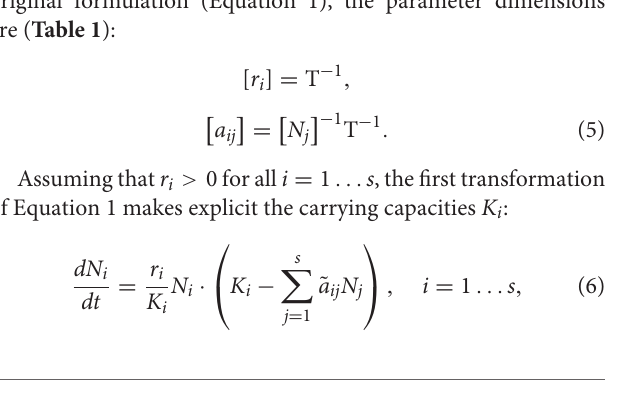
TABLE 1 | Parameter dimensions of the generalized Lotka–Volterra model and its reparameterizations. Parameter Dimension Intrinsic growth rate r